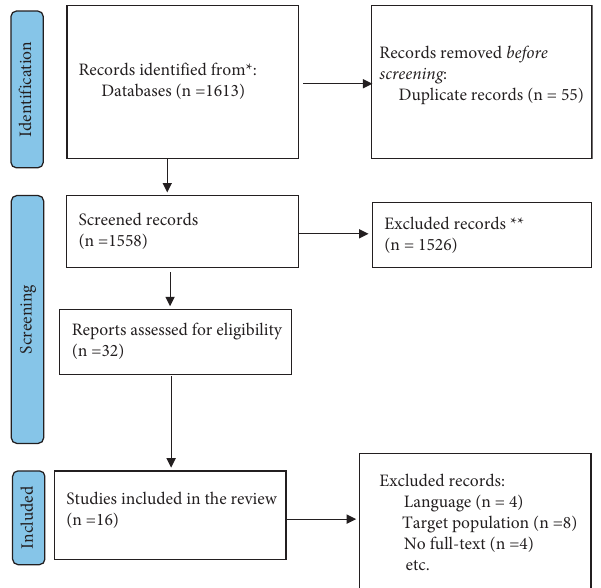
Figure 1: Reporting items for systematic reviews flowchart of the included